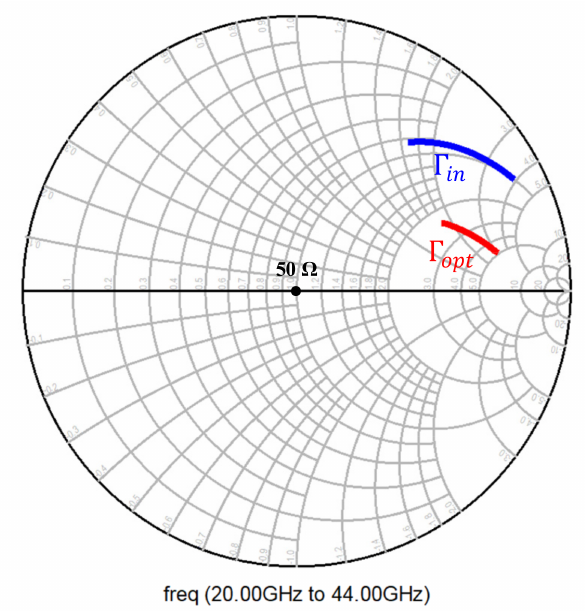
Figure 8. Γ in and Γ opt for a common-emitter CBEBC HBT with inductive emitter